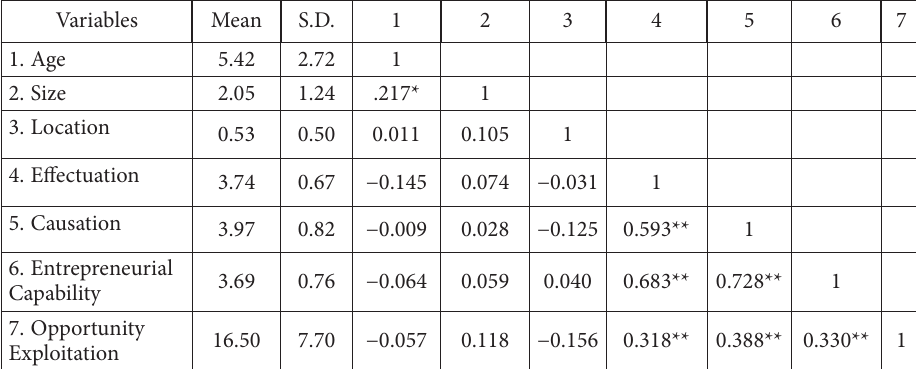
Table 1. Descriptive statistics and correlation Variables